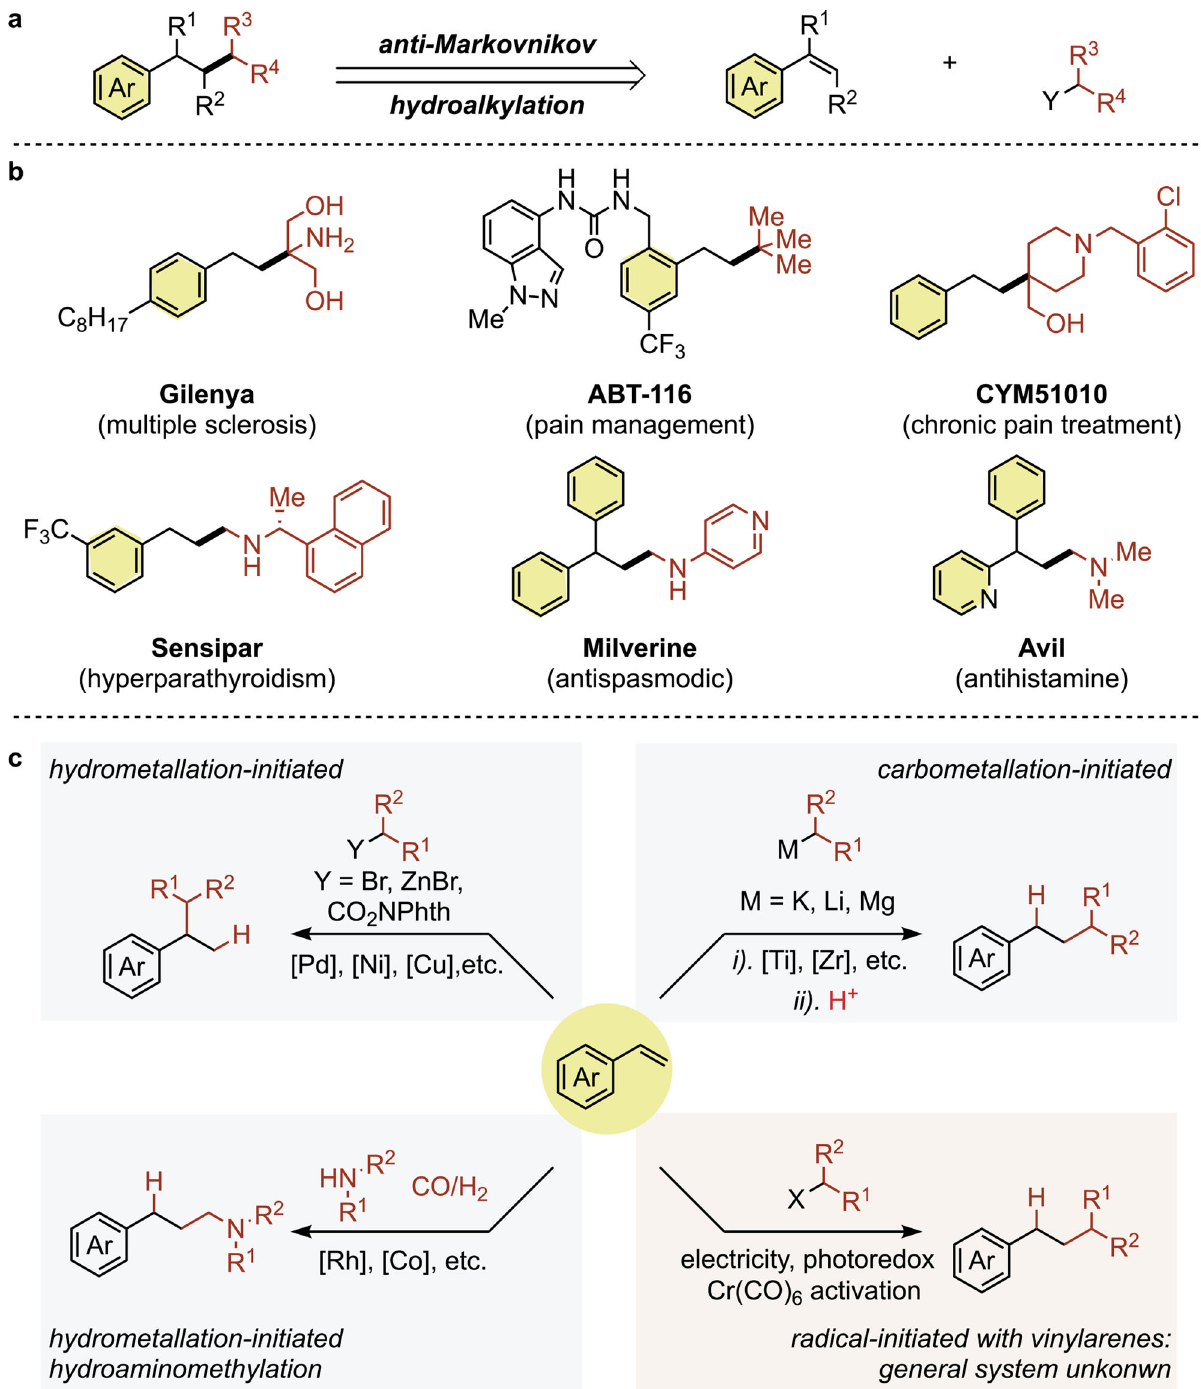
of simple styrene derivatives. b Biologically active molecules containing ( γ -amino) alkylated arenes. c Literature reports for hydroalkylation of styrenes: hydrometallation-initiated Markovnikov hydroalkylation; carbometallation-initiated anti-Markovnikov hydroalkylation; hydrometallation-initiated anti- Markovnikov hydroaminomethylation using syngas; and radical-initiated anti-Markovnikov